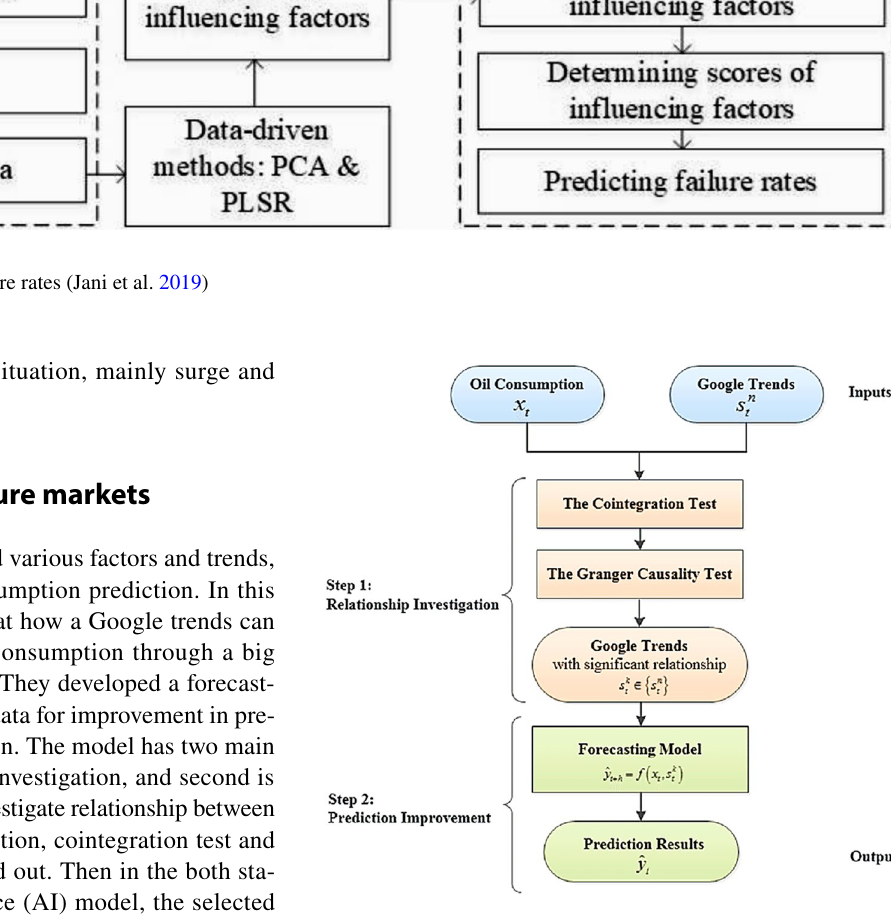
Fig. 6 General framework of an online big data-driven forecasting model using Google trends for oil consumption (Pandya et al.